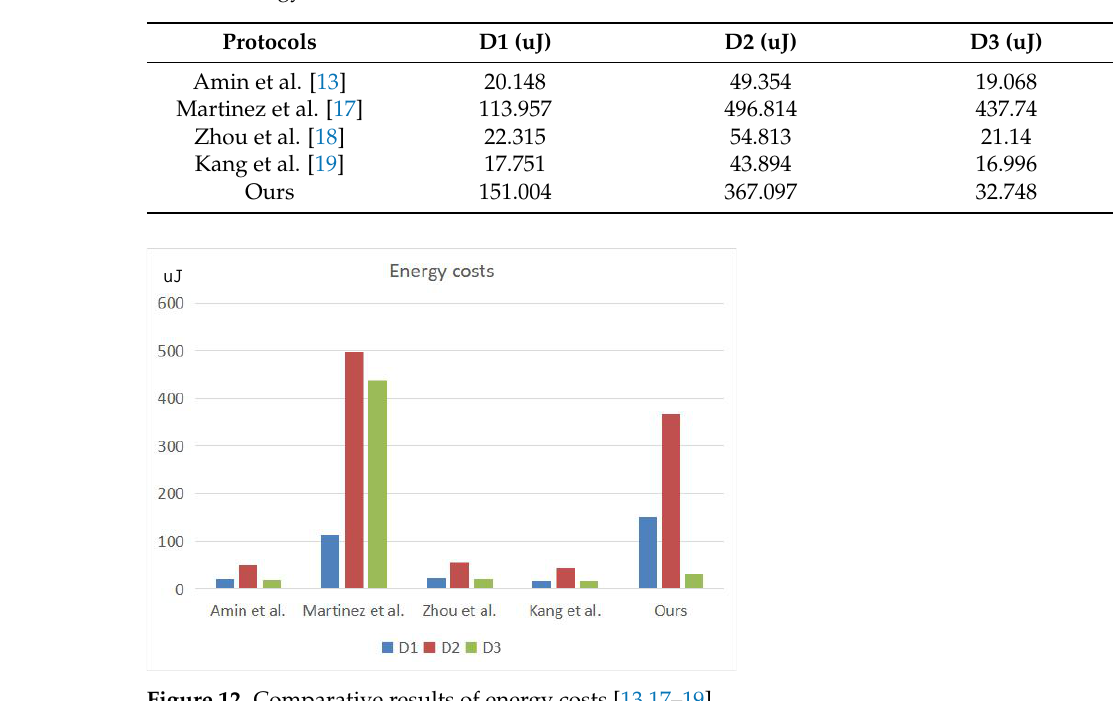
Table 9. Energy costs.